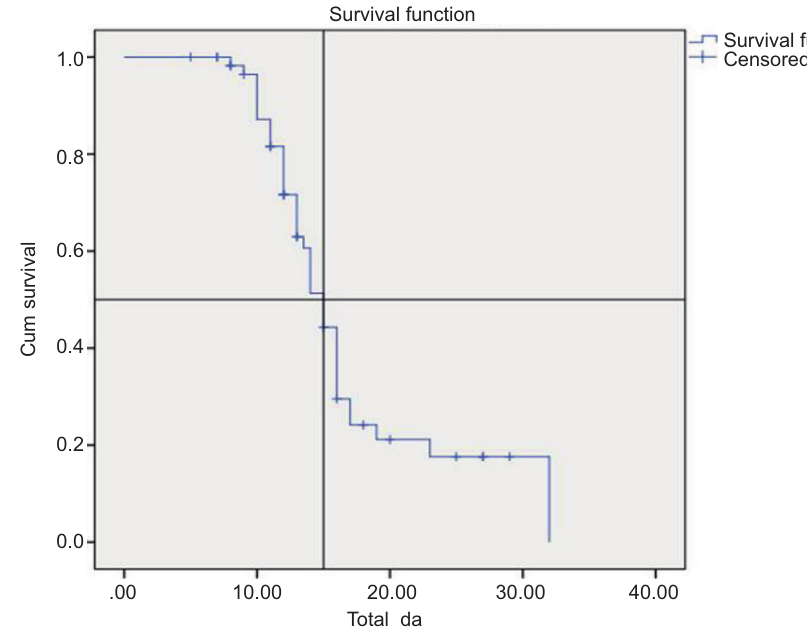
Figure 3: The probability of surviving 15 days in total period (latent period + hospital stay) is 50%.